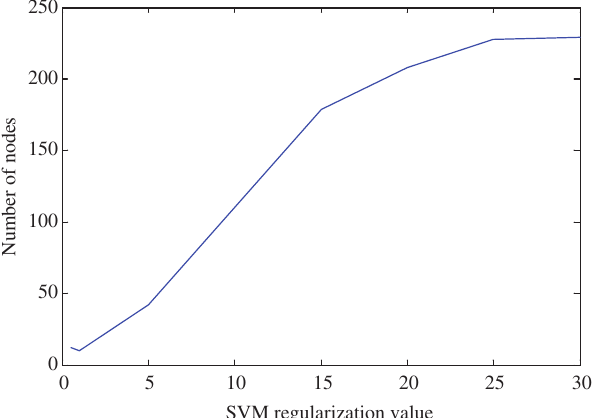
Figure 2: Impact of Regularization Factor on Number of